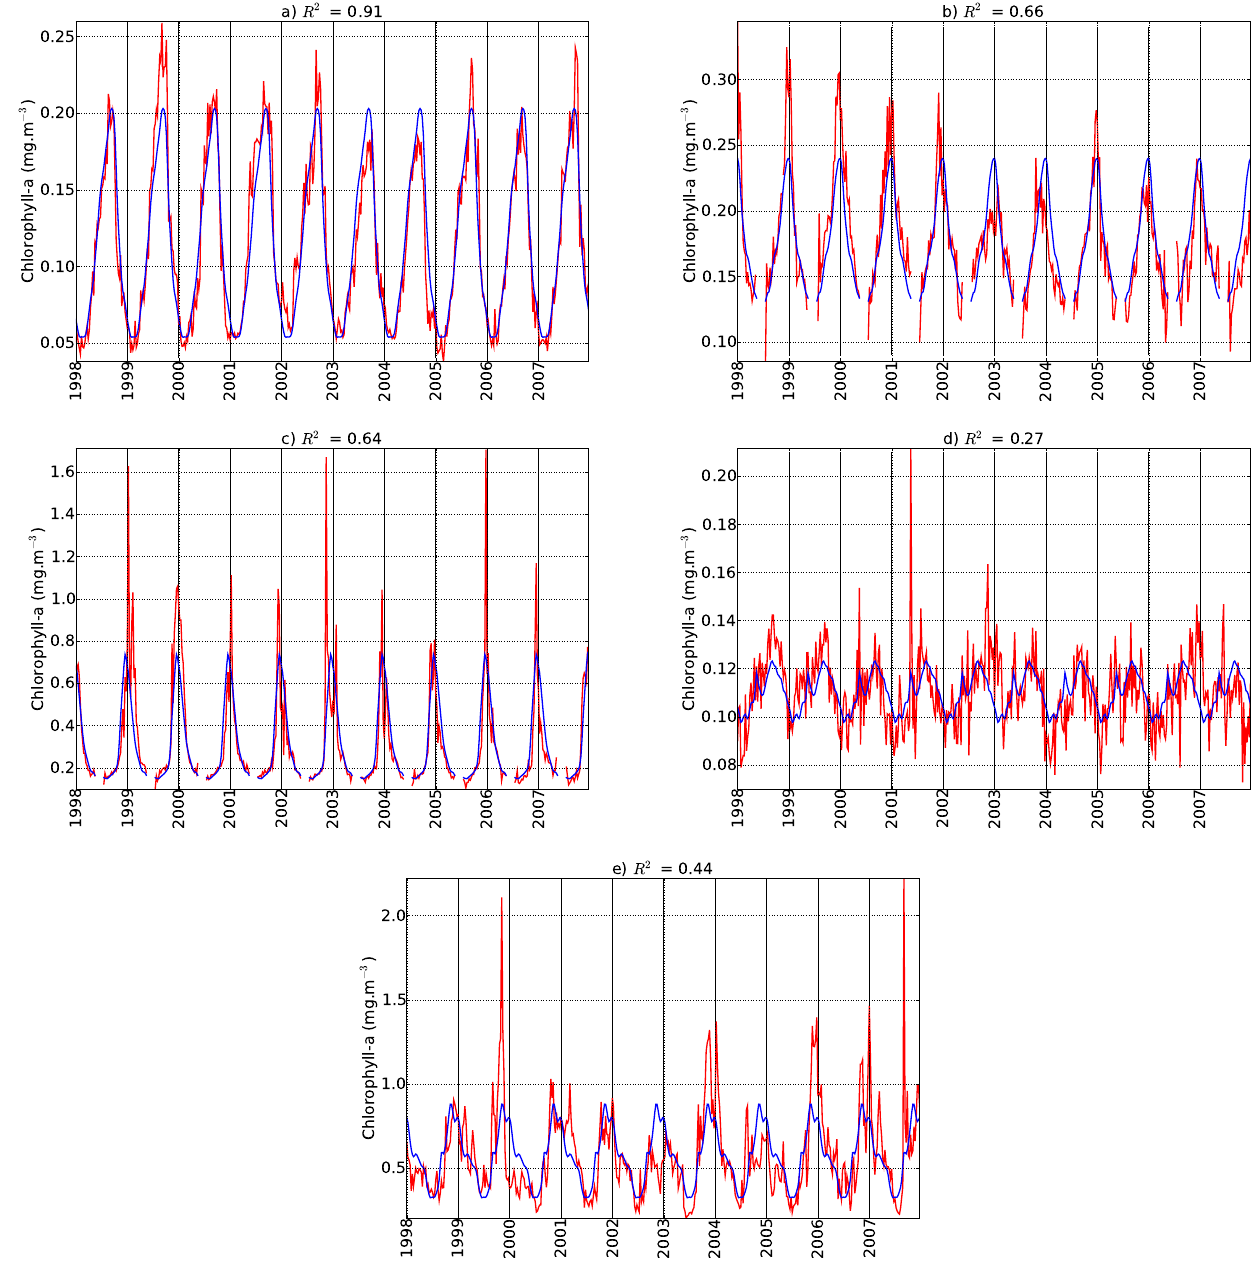
Fig. 5. Time series of chlorophyll concentrations from 1998 to 2007 (in red) compared to the climatological mean seasonal cycle (calculated over the 9yr) (in blue) for 5 × 5 degree blocks in (a) a region of high seasonal cycle reproducibility in the low chlorophyll STZ (30–35 ◦ S, 0–5 ◦ W), (b) a region of high seasonal cycle reproducibility in the low chlorophyll ACZ west of Kerguellen (50–55 ◦ S, 55–60 ◦ E), (c) a region of high seasonal cycle reproducibility and high chlorophyll in the ACZ, downstream of Kerguellen (50–55 ◦ S, 70–75 ◦ E), (d) a region of low seasonal cycle reproducibility and low chlorophyll in the TZ of the Pacific (40–45 ◦ S, 95–100 ◦ W) and (e) a region of low seasonal cycle reproducibility and high chlorophyll in the TZ off the east coast of South America (40–45 ◦ S, 50–55 ◦ W). The percentage of variance explained by the regression of the time-series (red) onto the mean seasonal cycle (blue) is shown on the figure ( R 2 ) . All correlations are statistically significant at the 99% confidence